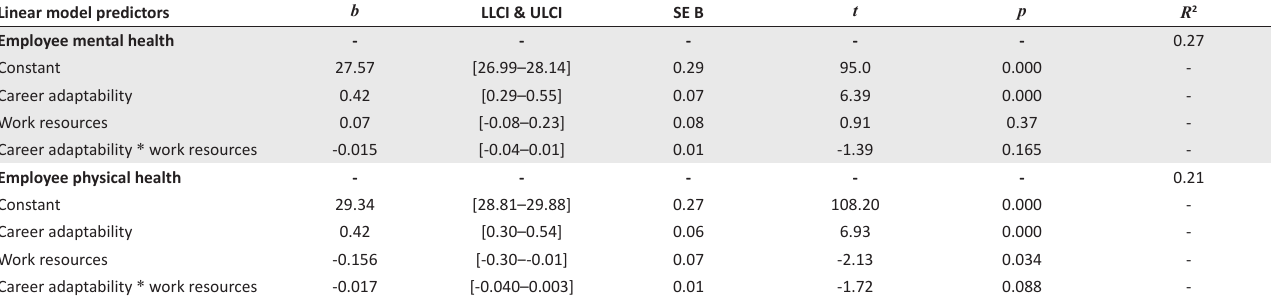
TABLE 5: Linear model of predictors of employee mental and physical health. Linear model predictors